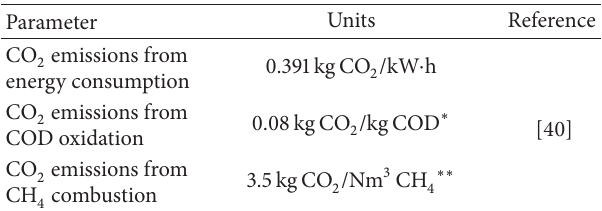
Table 1: Values assigned to the parameters used to estimate CO 2 emissions.